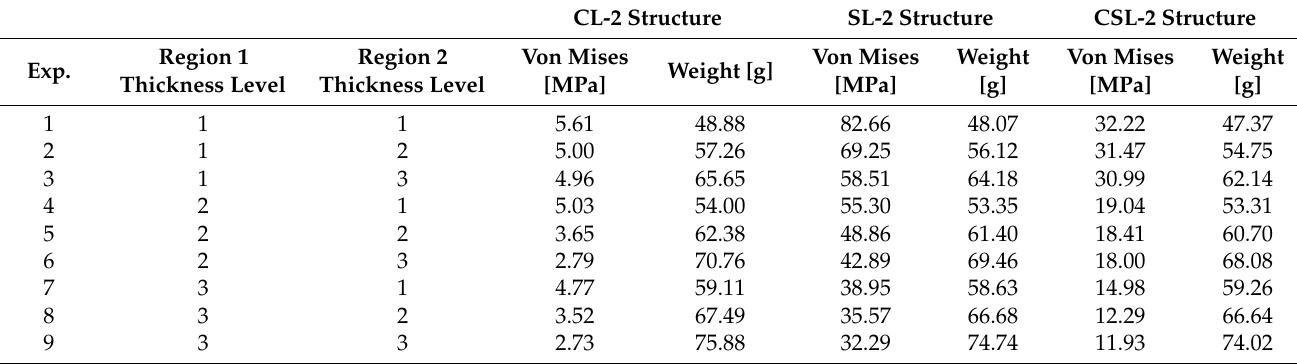
Table 6. L9 DOE of von Mises and weight for the CL-2, SL-2, and CSL-2 configurations.